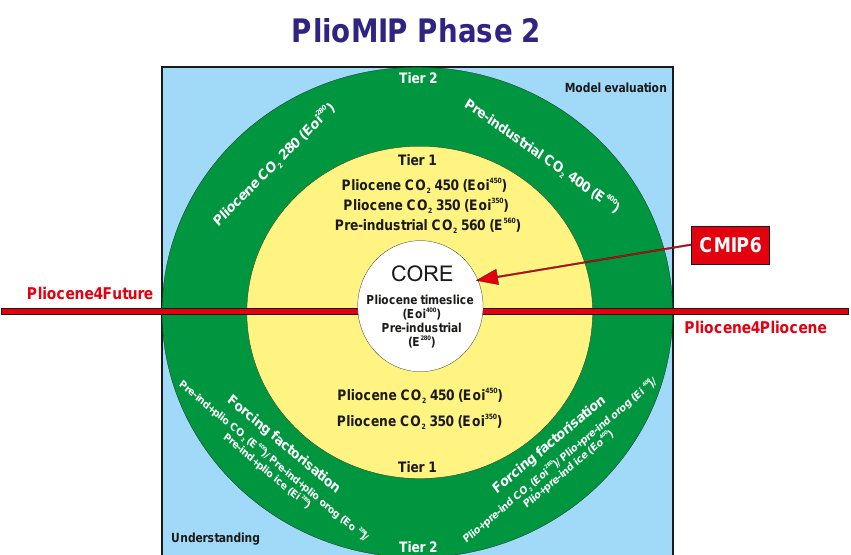
Figure 2. Experimental design strategy adopted for PlioMIP Phase 2. Core experiments will be completed by all model groups. Tier 1 and Tier 2 in either “Pliocene4Future” or “Pliocene4Pliocene” describe a series of sensitivity tests (Tier 1 being a higher priority for completion than Tier 2). Please note that Pliocene4Future Tier 1 experiment Pre-Industrial CO 2 400 also appears as a Tier 2 Pliocene4Pliocene exper- iment (Pre-Ind + PlioCO 2 ). See Table 3 for the naming convention and further details of all PlioMIP Phase 2 experiments, as well as